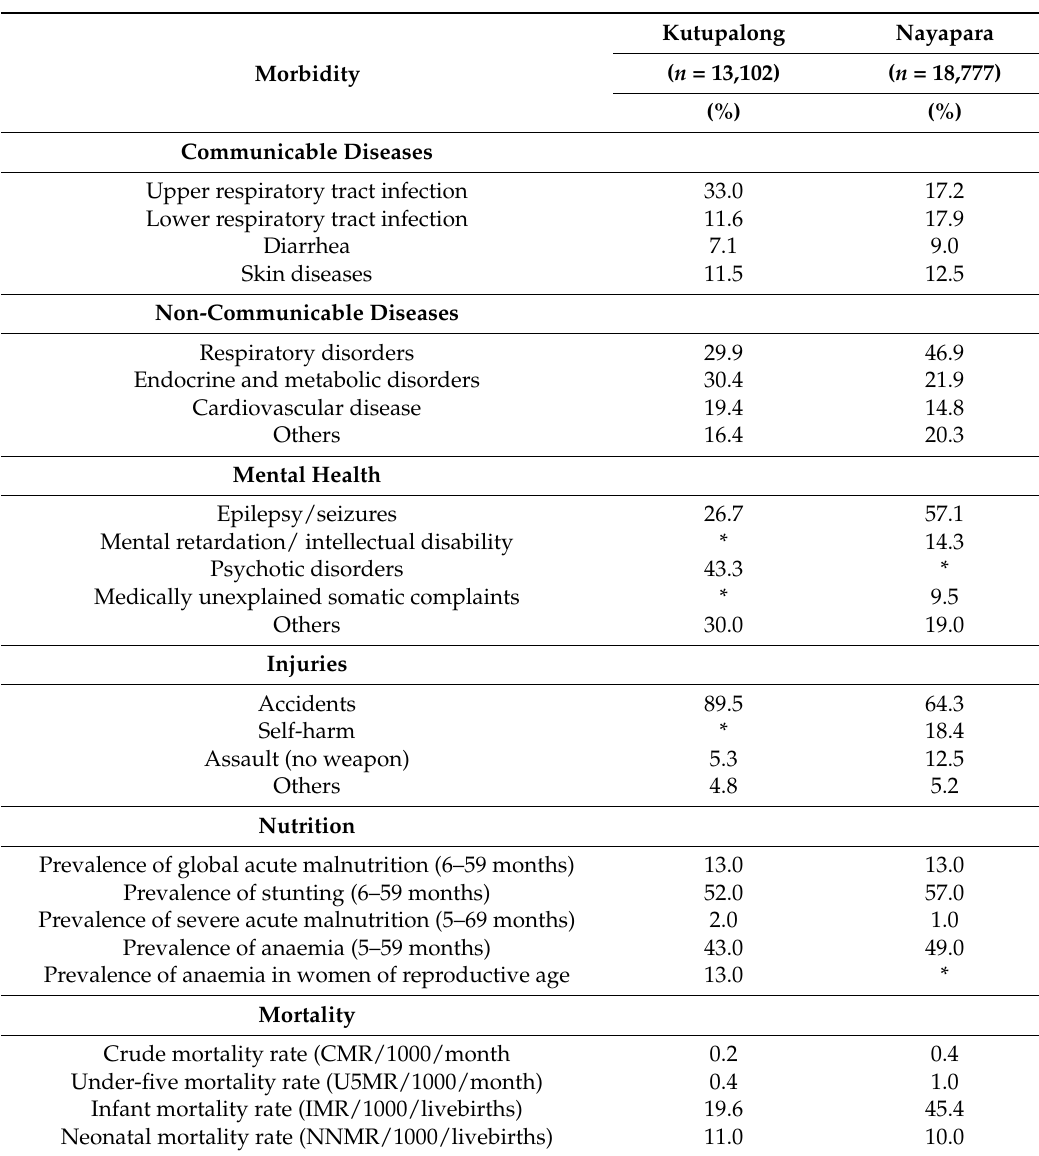
Table 3. Camp information on morbidity and mortality, UNHCR, 2015